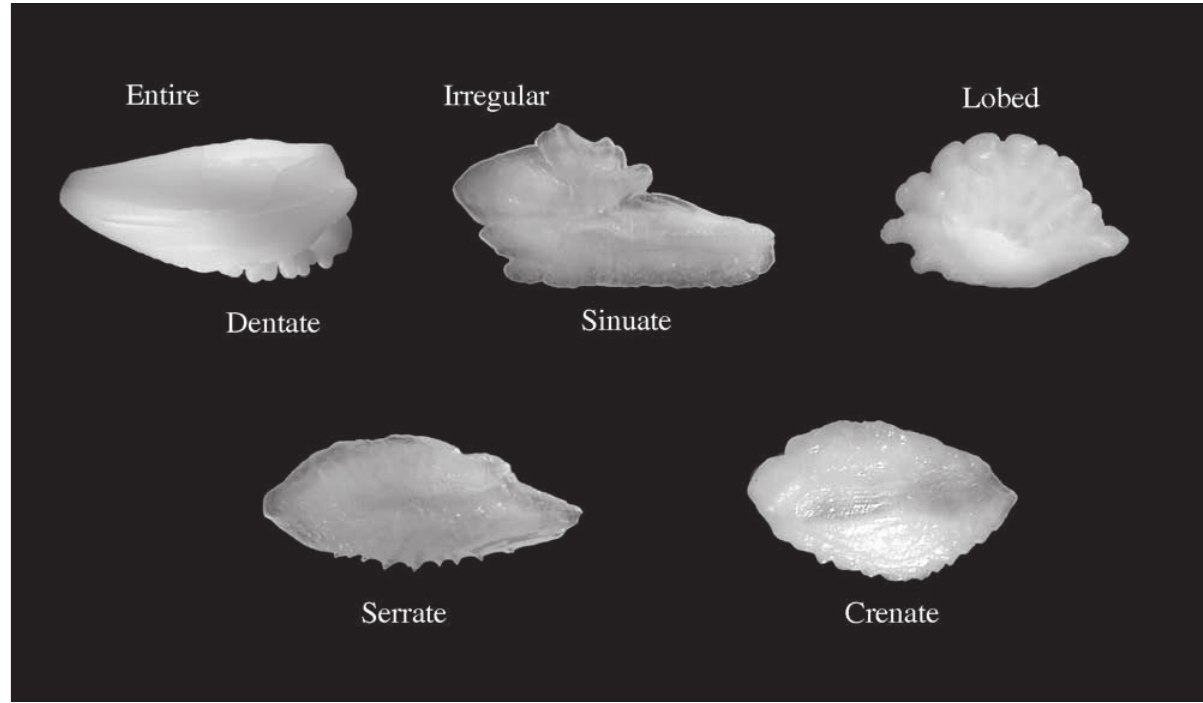
Fig. 9. – Terms used to describe the sculpture of the otolith